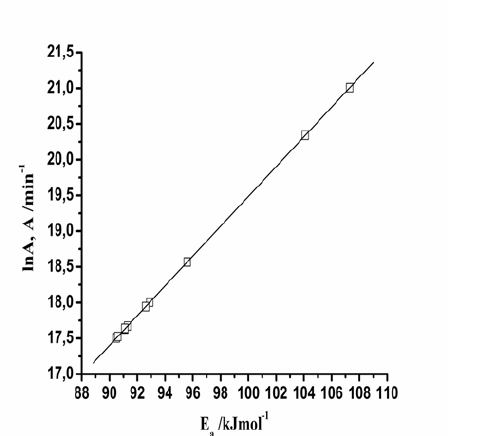
Figure 8 – The true compensation effect (lnA vs. E a ) evaluated from the isoconversional Friedman’s method, for the reduction process of NiO under hydrogen atmosphere Slika 8. – Istiniti kompenzacioni efekat (lnA naspram E a ) izveden iz izokonverzione Frid- manove metode za proces redukcije NiO pod atmosferom